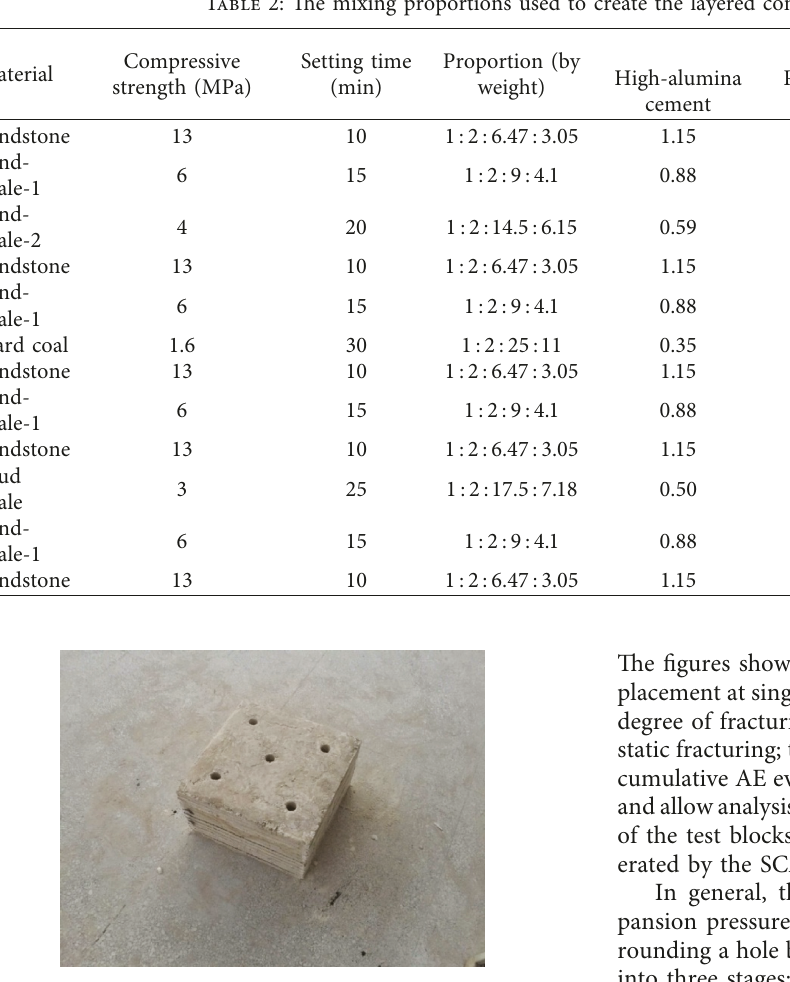
Table 2: The mixing proportions used to create the layered concrete test block [28].